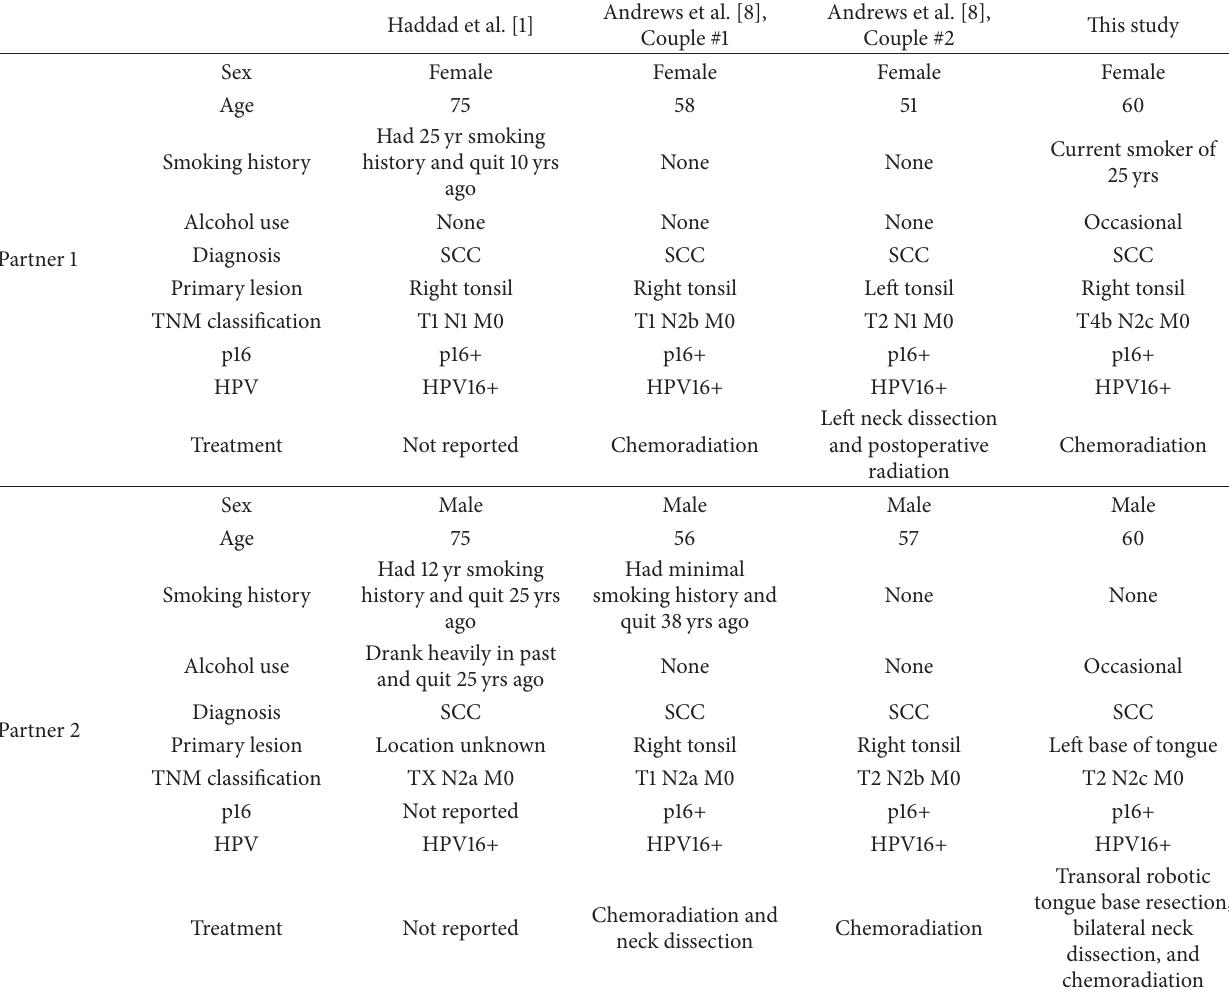
Table 1: Published cases of synchronous presentation of human papillomavirus-positive oropharynx squamous cell carcinoma among